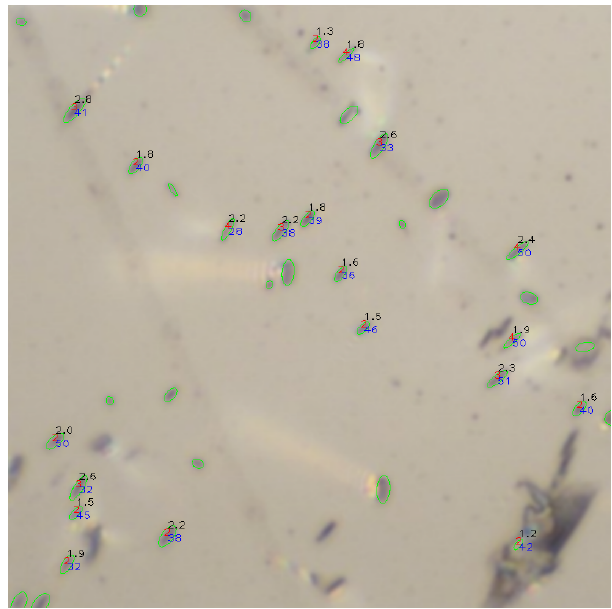
Figure 3. An example of a semi-automatic D par measurement re- sult obtained on a part of an image taken at 1000 × magnification. The green ellipses are the remainders of a segmentation process. The values written next to the ellipses stand for the length in mi- crometres (black), the elongation factor (red), and the angle (blue). Some green ellipses show no values because they have been ex- cluded by the elongation filter, direction filter, minimum size filter, or maximum size